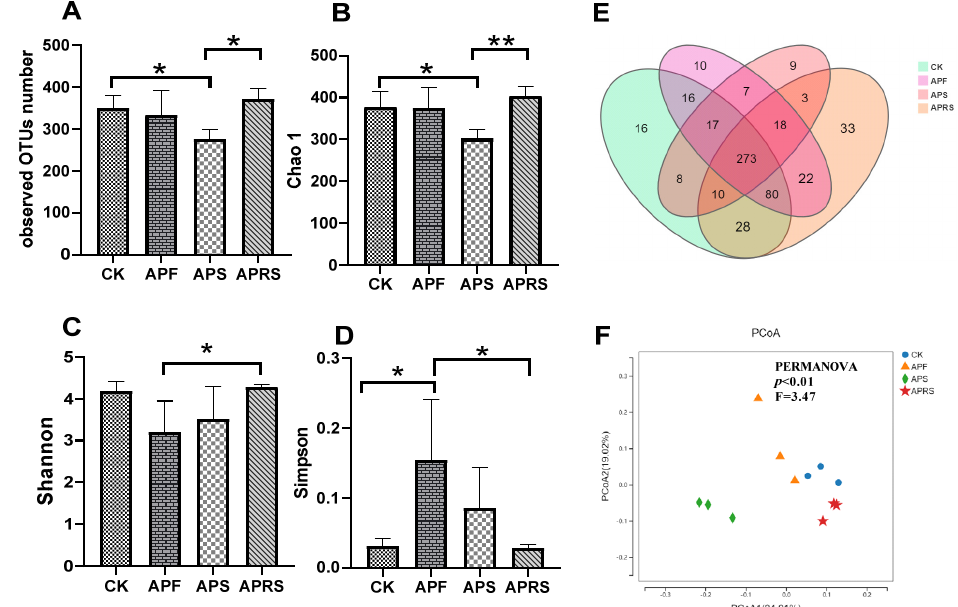
Figure 1. Alpha- and beta-diversity comparisons of fecal microbiome from mice after 8 weeks of feeding with APF, APS, and APRS. ( A ) Observed OTU number, ( B ) Chao 1, ( C ) Shannon, and ( D ) Simpson, * p < 0.05, ** p < 0.01 (one-way ANOVA). ( E ) Venn diagram showing the unique and shared OTUs among the groups. ( F ) PCoA plot of beta diversity based on unweighted UniFrac distance.